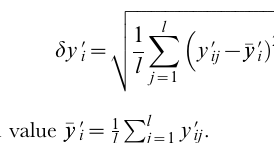
Figure S1 Found at: doi:10.1371/journal.pone.0008653.s001 (2.90 MB TIF) Figure S2 Found at: doi:10.1371/journal.pone.0008653.s002 (6.84 MB TIF) Figure S3 Model probabilities of population ratio of quiescent to active cells for b -cells and ductal epithelial cells of Cdk4 WT and Cdk4 R/R